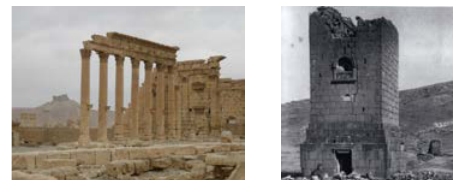
Figure 1. Temple of Bel (left) and tower tomb of Elahbel (right). Photos taken by T. Paulette in 2005 and by Wolfe Expedition in 1885,